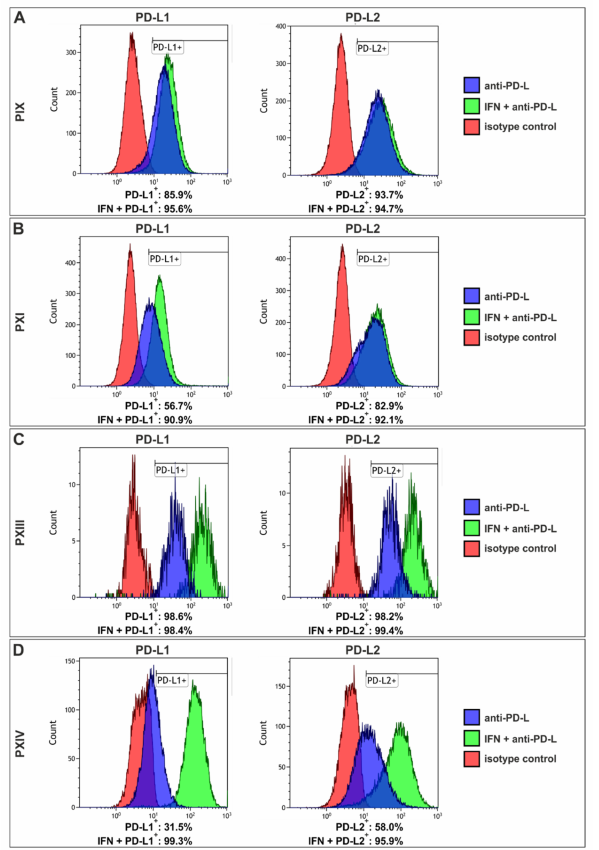
Figure 4. Prostate cancer stem cells showed enhanced affinity to programmed cell death 1 after interferon treatment. ( A ) Flow cytometry of the PIX prostate cancer stem cell (PCSC) population depicted increased expressions of the programmed cell death 1 ligand 1 (PD-L1; left panel) after 72 h of incubation with interferon gamma (IFN γ ; green graph), in comparison with untreated PCSCs (blue graph). Analyses of PD-L2 expressions (right panel) showed no effect of IFN γ pre-treatment. ( B ) PXI PCSCs also displayed a strong increase in PD-L1 + cells after incubation with IFN γ (left panel), as compared to the expression of PD-L1 alone. The analysis of PD-L2 showed a difference of 9% in positive cells between pre- and untreated PCSCs. ( C ) PXIII PCSCs contained 98% of both PD-L positive stained cells, independent of IFN γ . ( D ) The PCSCs population PXIV revealed the highest increase in PD-L + cells after treatment with IFN γ , up to 67% (PD-L1). For all analyses, red graphs display the isotype